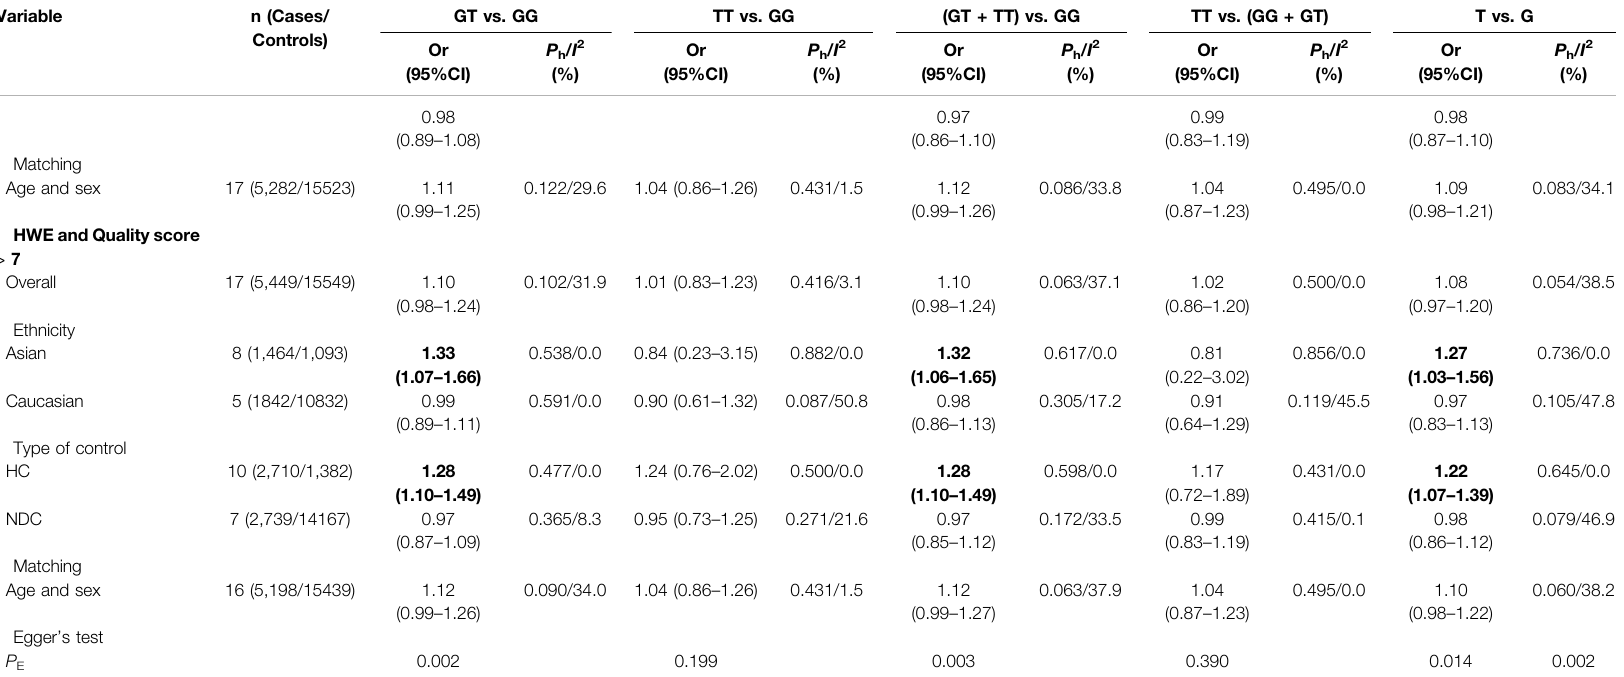
TABLE 7 | ( Continued ) Meta-analysis of the association of eNOS G894T polymorphism with risk of